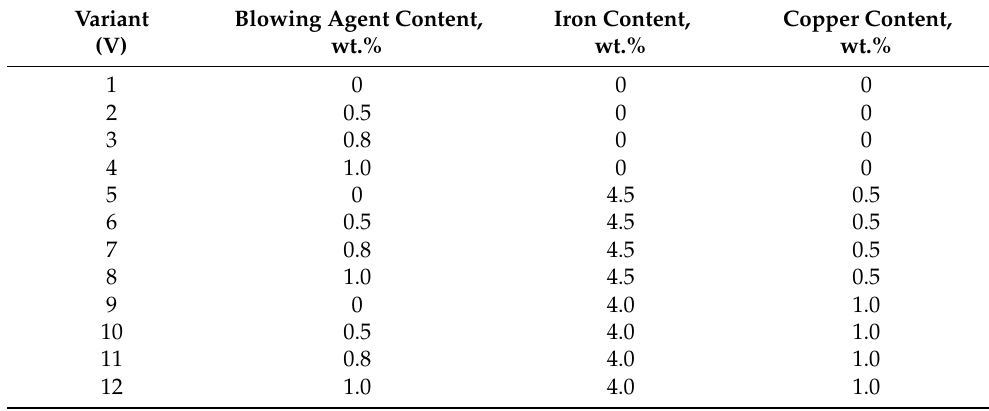
Table 1. Numerical values of the variable